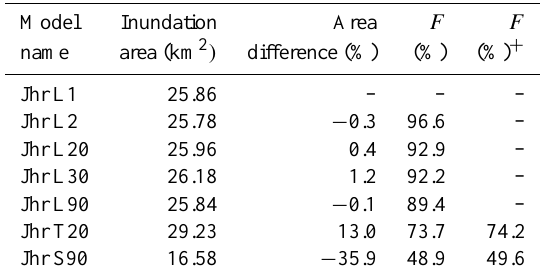
Table 7. Summary of mean absolute difference (MAD) in terms of water surface elevation simulated by the